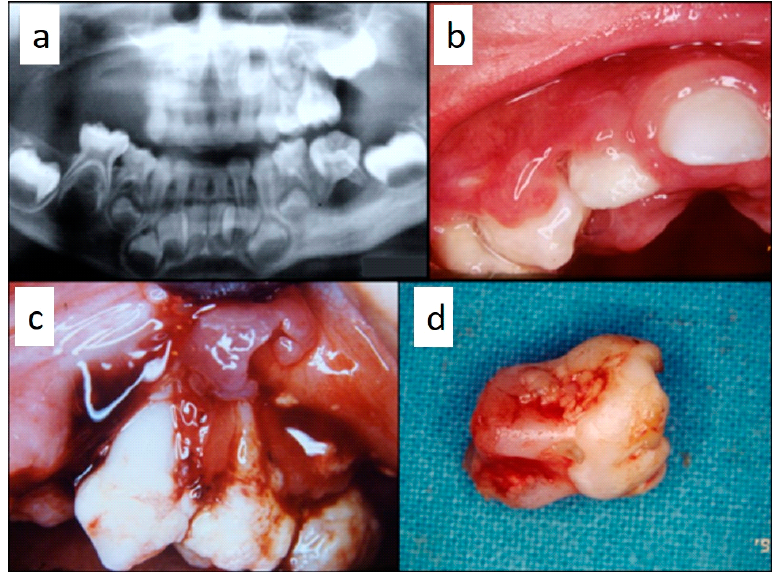
Figure 2. ( a – d ): Primary periodontal manifestations of LCH in a 5-year-old male: multiple osteolytic lesions in the mandible and in the maxilla ( a ) associated with gingival overgrowth and inflammation ( b ) and to painful ulceration of the gingiva with radicular exposure, bone loss ( c ) and tooth mobility with incomplete radicular formation due to the dental follicle involvement ( d ).